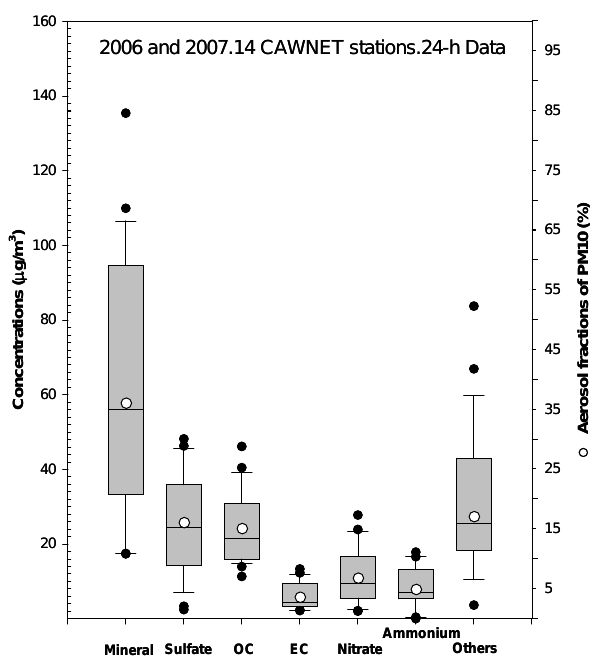
Fig. 2. Annual averaged mass concentrations (median of the box plot) of aerosol chemical species and its percentage (open circle) of PM 10 in China. The bottom and up of the box plot represents 25% and 75%